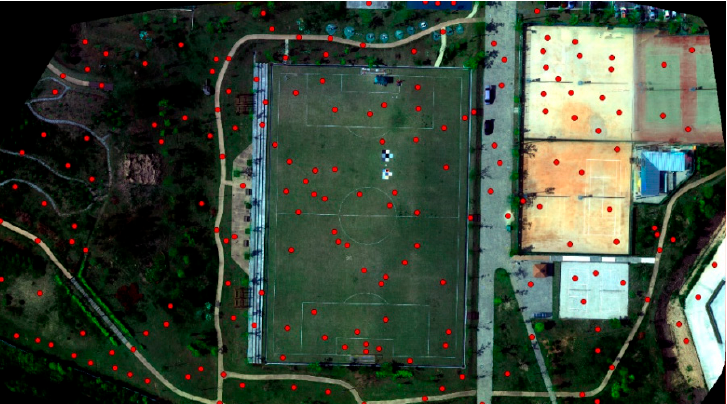
Figure 12. Distribution of validation points within the mosaicked image.